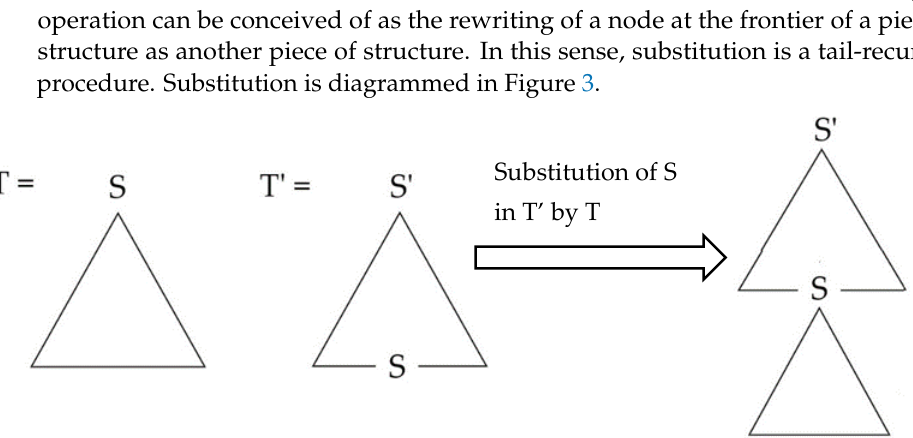
Figure 2. Auxiliary tree.